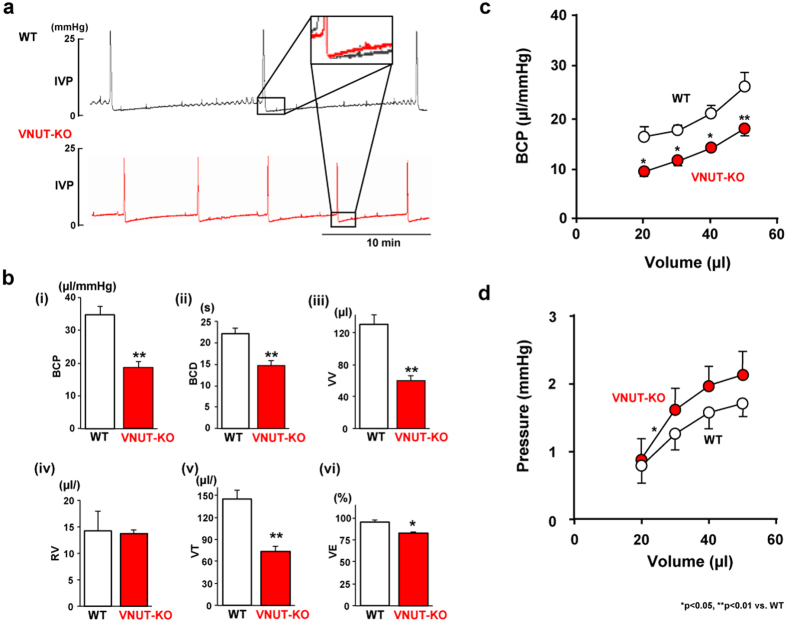
Cystometry in decerebrate, unanaesthetised WT and VNUT-KO mice.(a) Cystometry chart of decerebrate, unanaesthetised mice. Typical bladder activity during continuous saline infusion is shown by CMGs (infusion rate: 10 μl/min) from a WT and a VNUT-KO mouse. The inset shows magnified superimposed images from the two CMGs to show the difference in intravesical pressure during the early phase of bladder filling. (b) Results of cystometry in decerebrate, unanaesthetised WT (n = 7) and VNUT-KO (n = 7) mice. (i) Bladder compliance (BCP), (ii) bladder contraction duration (BCD), (iii) voided volume (VV), (iv) residual volume (RV), (v) volume threshold (VT) and (vi) voiding efficacy (VE). BCD (s) is the duration from the pressure threshold (PT, mmHg), which is the intraluminal pressure required to induce a voiding contraction, to resting pressure (RP, mmHg), which is the lowest pressure immediately after a voiding contraction54. VV (μl) is the volume fluid voided from the urethral meatus60. RV (in μl) is the volume of fluid remaining in the intravesical space. VT (μl) is the volume that induces micturition, calculated as the sum of the voided and residual volume. From these values, voiding efficiency (VE; %) was estimated as follows: VE = VV/VT × 100. The other parameters evaluated were pressure at volume threshold for inducing micturition contraction (mmHg), maximal voiding pressure (mmHg), closing peak pressure (mmHg), and bladder compliance (μl/mmHg)6061. Bladder compliance (BCP) was calculated as the ratio of the infused volume to the pressure difference between the post-void resting pressure and the following pressure at the volume threshold for inducing micturition contraction. (c) Intravesical volume: mean BCP analysis (from 20 to 50 μl). (d) Intravesical volume: pressure relation analysis (from 20 to 50 μl). Data are mean ± SEM. Asterisks show significant differences in response between VNUT-KO and WT mice (*P < 0.05, **P < 0.01) (Mann–Whitney U test). An asterisk in (d) indicates a significant difference in the slope (from 20 to 30 μl) between the groups (*P < 0.05).